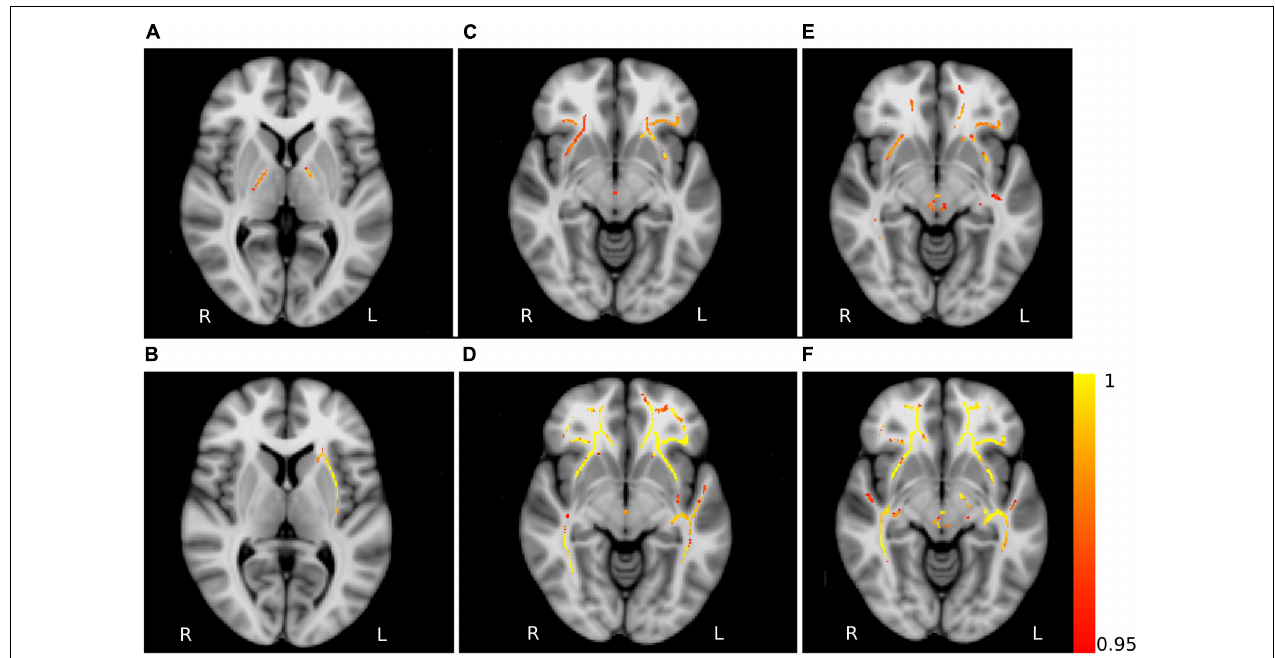
FIGURE 5 | Non-FA diffusivity measures differences. Axial slices of non-FA measures: axial diffusivity obtained for the contrasts HC Y > PD (A) and HC Y < PD (B) , mean diffusivity for the contrasts HC M < PD (C) and HC Y < PD (D) , radial diffusivity for the contrasts HC M < PD (E) and HC Y < PD (F) . The slices show the results after the threshold free cluster enhancement (TFCE) thresholding ( p < 0.05, FWE corrected), superimposed on the FSL’s 1 mm MNI152 standard brain. The scale [1 – p -value] represents the significance of the clusters with yellow indicating higher and red indicating lower statistical significance. L and R denote the left and right hemisphere of the